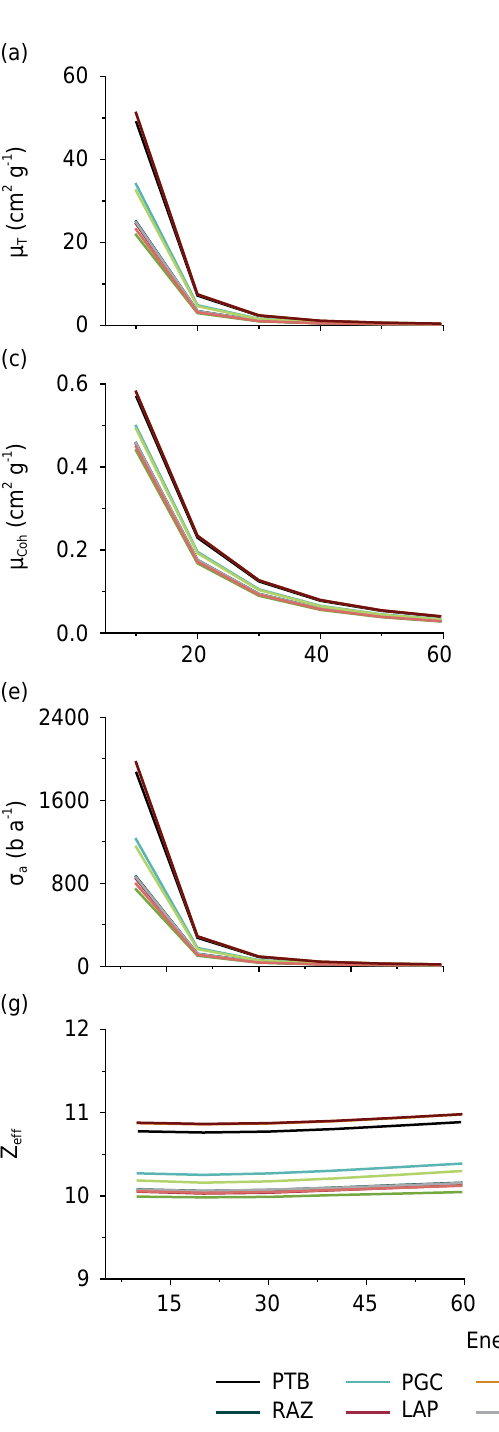
Figure 6. Variation of the total mass attenuation coefficient (μ T ) with energy (a), variation of the partial μ (photoelectric effect – Ph) with energy (b), variation of the partial μ (coherent scattering – Coh) with energy (c), variation of the partial μ (incoherent scattering – Incoh) with energy (d), variation of atomic cross-section (σ a ) with energy (e), variation of electronic cross section (σ e ) with energy (f), variation of effective atomic number (Z eff ) with energy (g), and variation of electron density (N el ) with energy (h). The acronyms utilized stand for the following municipalities: PTB (Pato Bragado), PGC (Ponta Grossa), STH (Santa Helena), MER (Mercedes), MOR (Morretes), RAZ (Rio Azul), LAP (Lapa), CAZ (Cerro Azul), JOT (Joaquim Távora), and PAR